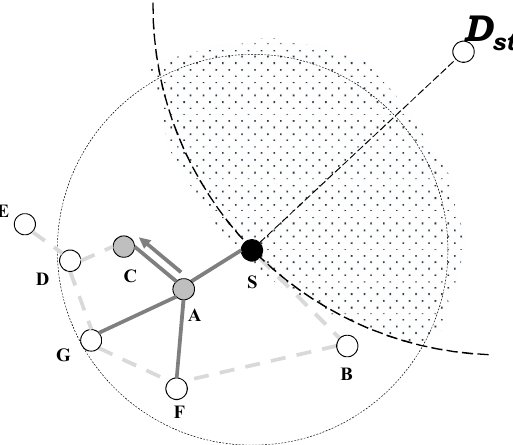
Figure 4. While the node A finds the candidate node C during face-routing, the node S identifies the node C by using the overhearing of the search